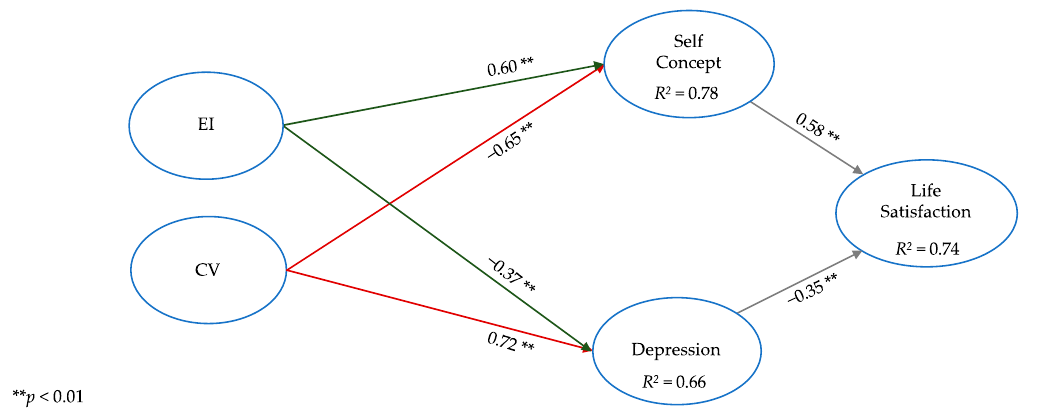
Figure1. Model1: Relationshipsbetweencybervictimization(CV)andemotionaladjustmentconstructs. Figure 1. Model 1: Relationships between cybervictimization (CV) and emotional adjustment constructs.